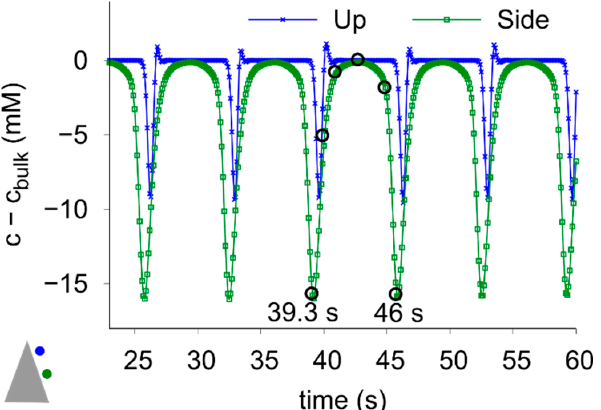
Figure 8. Numerical result of the concentration variation with respect to the bulk concentration for j cathode = 8 mA/cm 2 at the two monitoring points used in the experiments (Upper: (0.57, 1.93) mm; Side: (0.77, 1.02) mm, marked as white circles in Figure 9). The black circles indicate the points in time during the oscillation period discussed in Figure 9. (0, 0.1 T period , 0.25 T period , 0.5 T period , 0.85 T period , 1 T period ). The time interval shown starts at 23 s, after which a stable oscillation regime is observed.